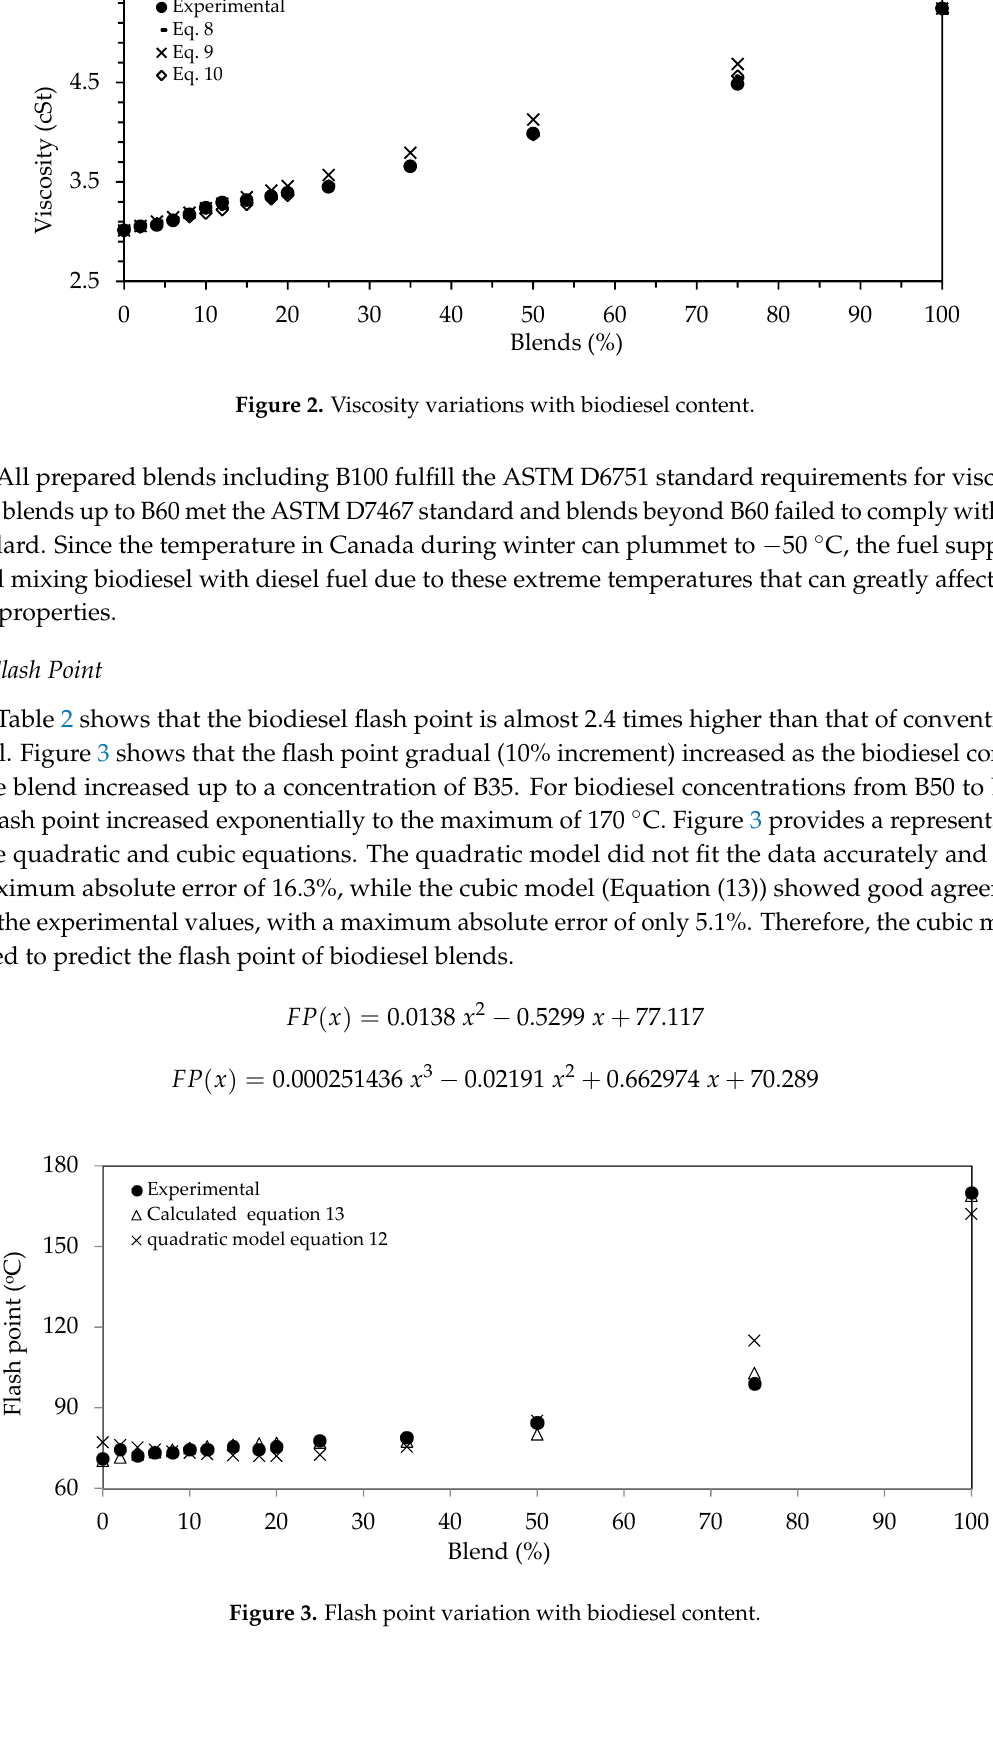
Figure 3. Flash point variation with biodiesel content.